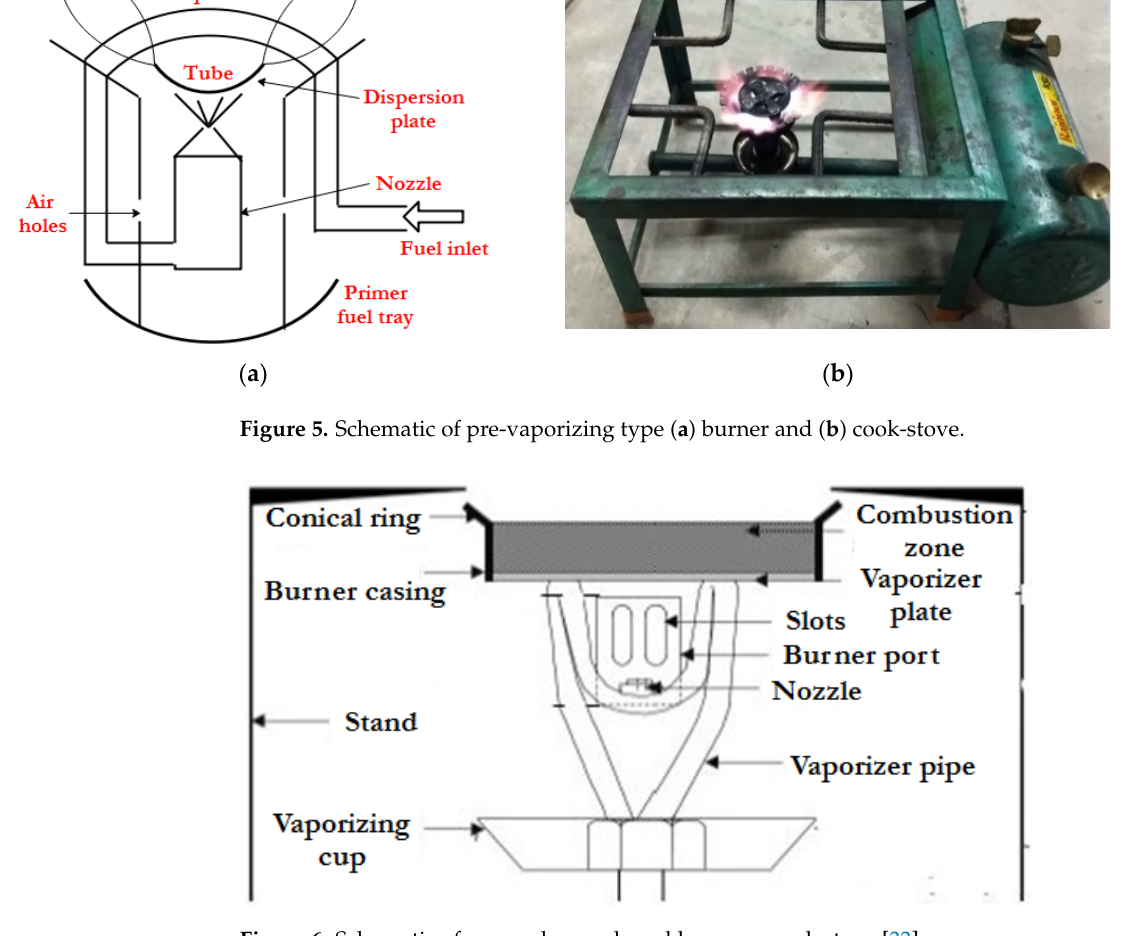
Figure 6. Schematic of porous burner based kerosene cook stove [33].